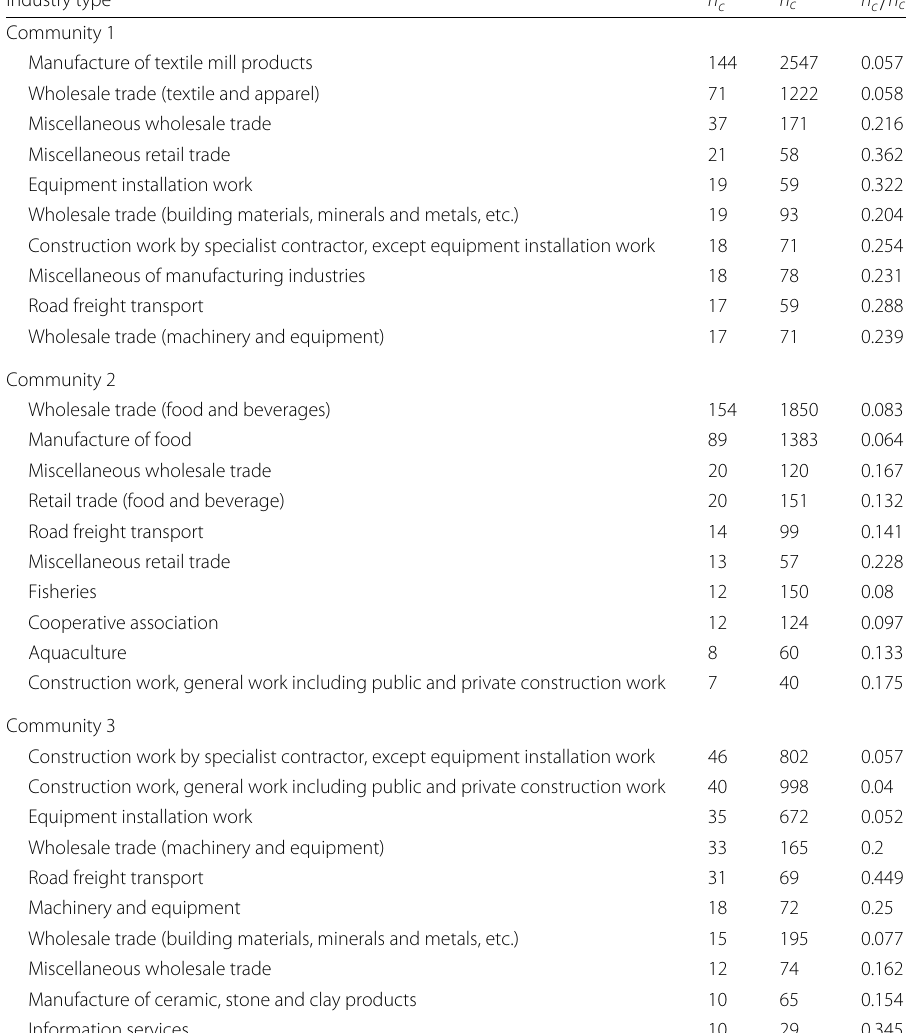
Table 6 Table of the number of firms n c for each industry type in the community, and the number of firms n (cid:2) that has the top 10% of the ξ ( c ) /ξ ( p ) value within the community c Industry type n (cid:2) c n c n (cid:2) c / n